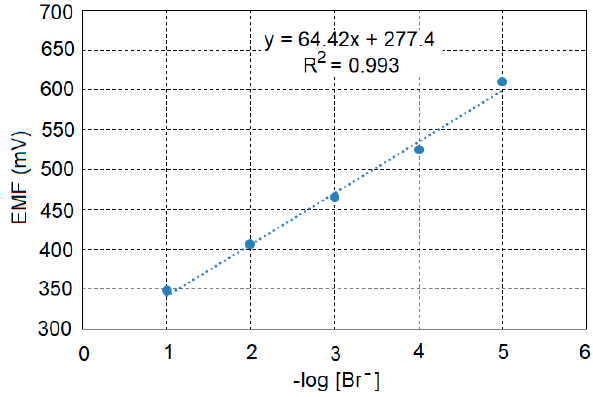
Figure 5. The potentiometric response of sensor B toward bromide.